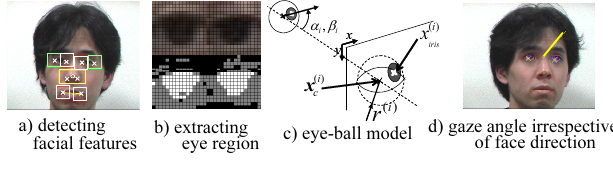
Figure 6. Results of Gaze-tracking